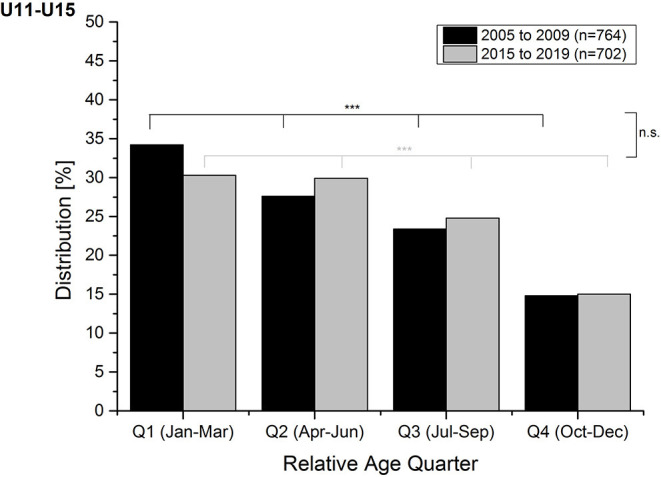
Relative age quarter distributions of former (2005–2009; black) and current (2015–2019; light gray) ski racers of all age groups (U11–U15). ***p < 0.001; n.s., not significant difference between groups.